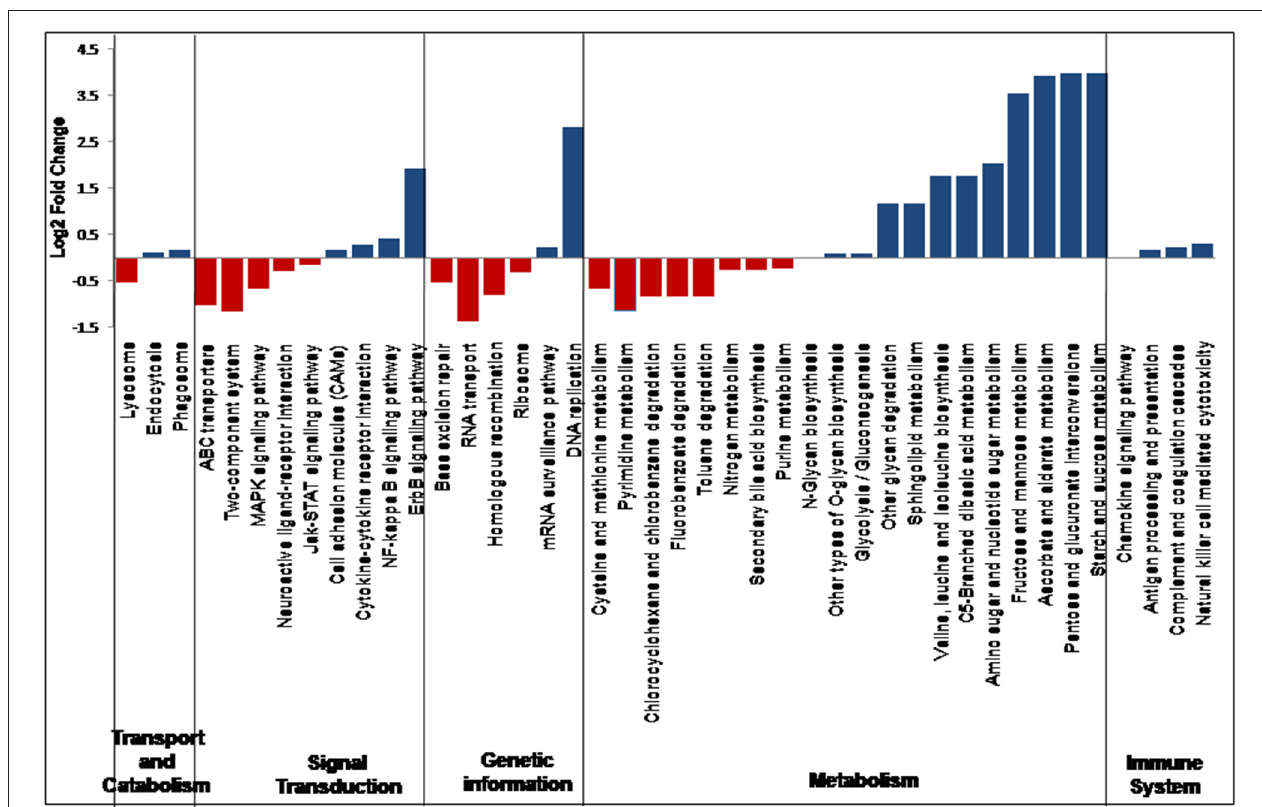
FIGURE 7 | Differential abundance in the discriminative KEGG pathways in VC compared to PFR